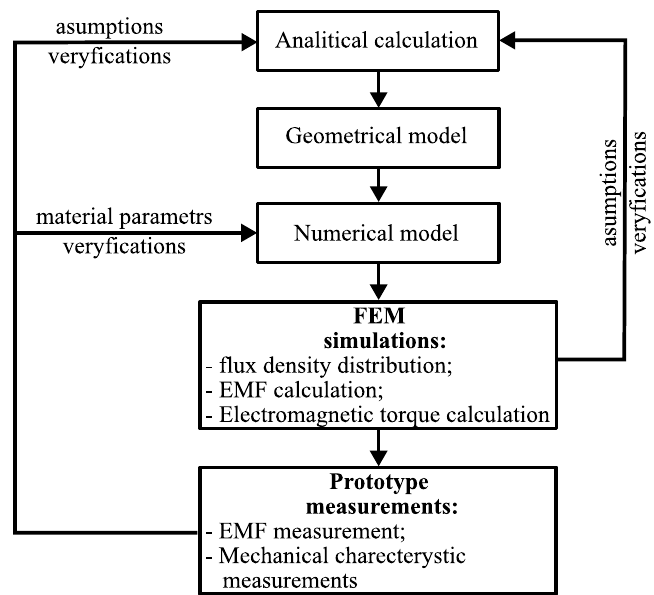
Figure 2. The general approach during the prototype design